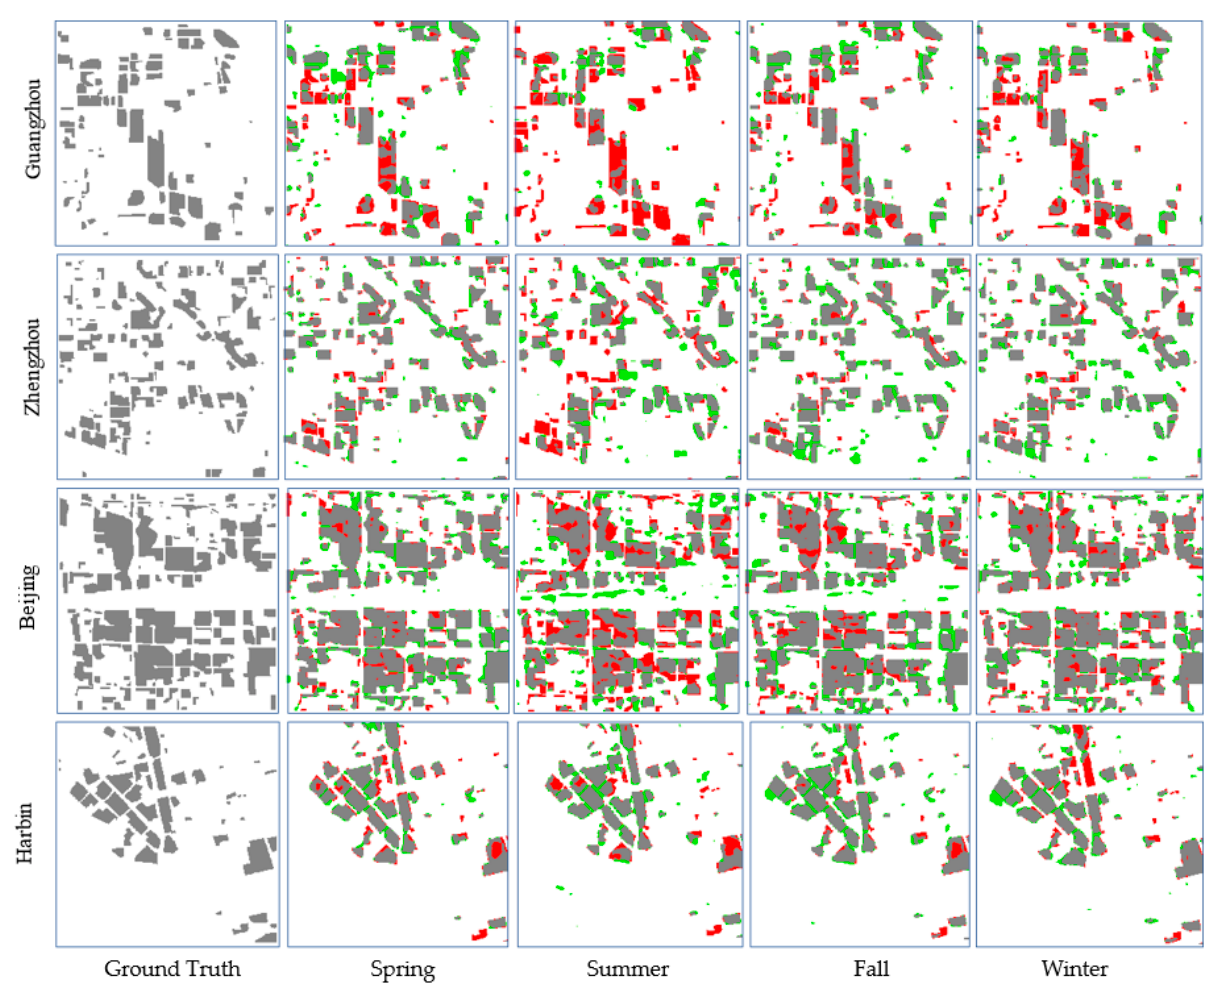
Figure 6. Ground truths and predicted HRBs in test1 in four regions in four seasons by FCN models trained on samples from each combination of season and region. Gray refers to true HRBs, red refer to omission errors, and green refer to commission errors.